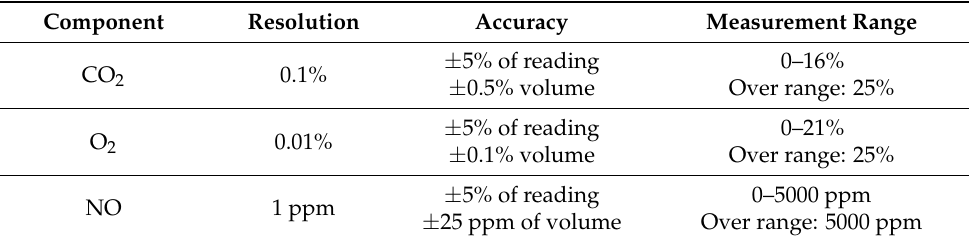
Table 2. Measurement range of the individual components of exhaust